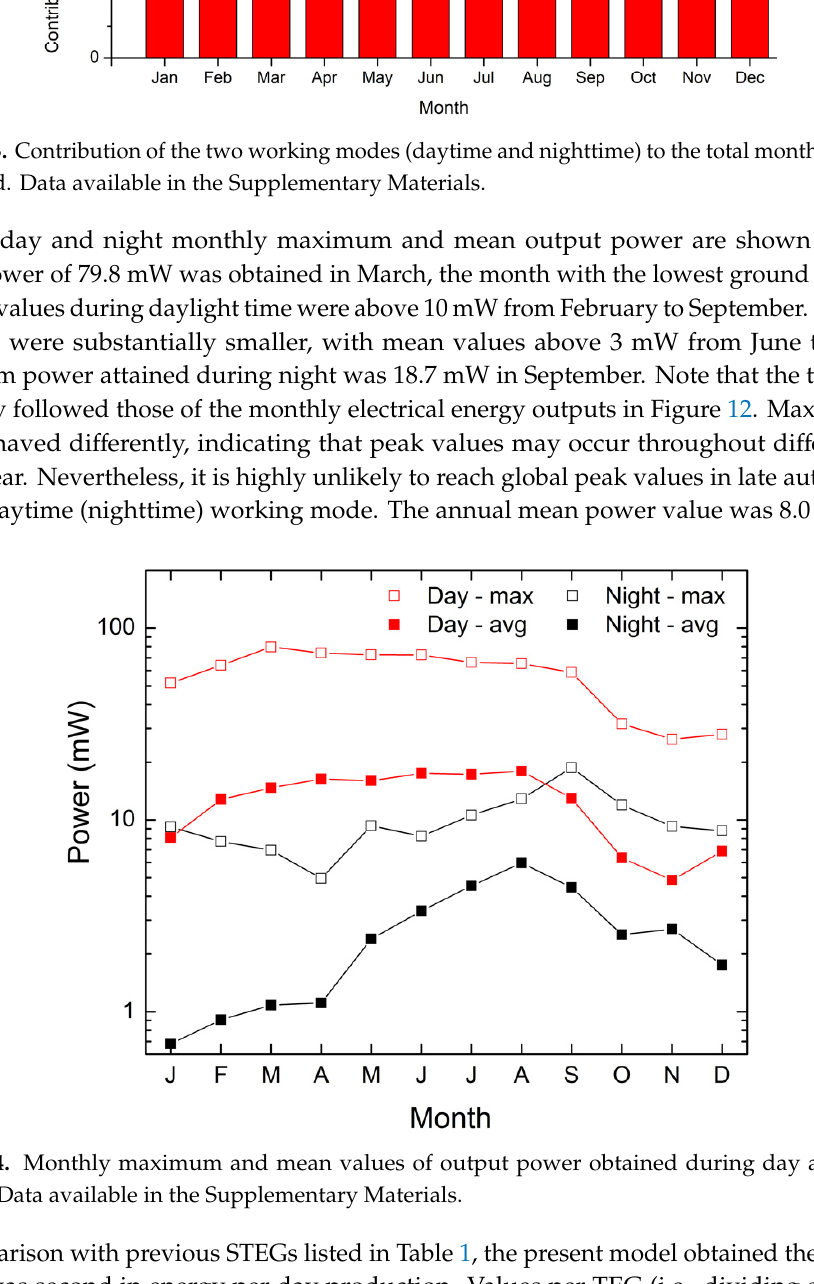
Figure 13. Contribution of the two working modes (daytime and nighttime) to the total monthly energy harvested. Data available in the Supplementary Materials.